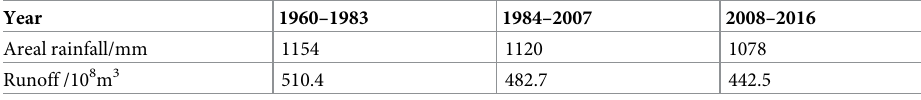
Table 4. Annual average rainfall and runoff at Wu Long Station.